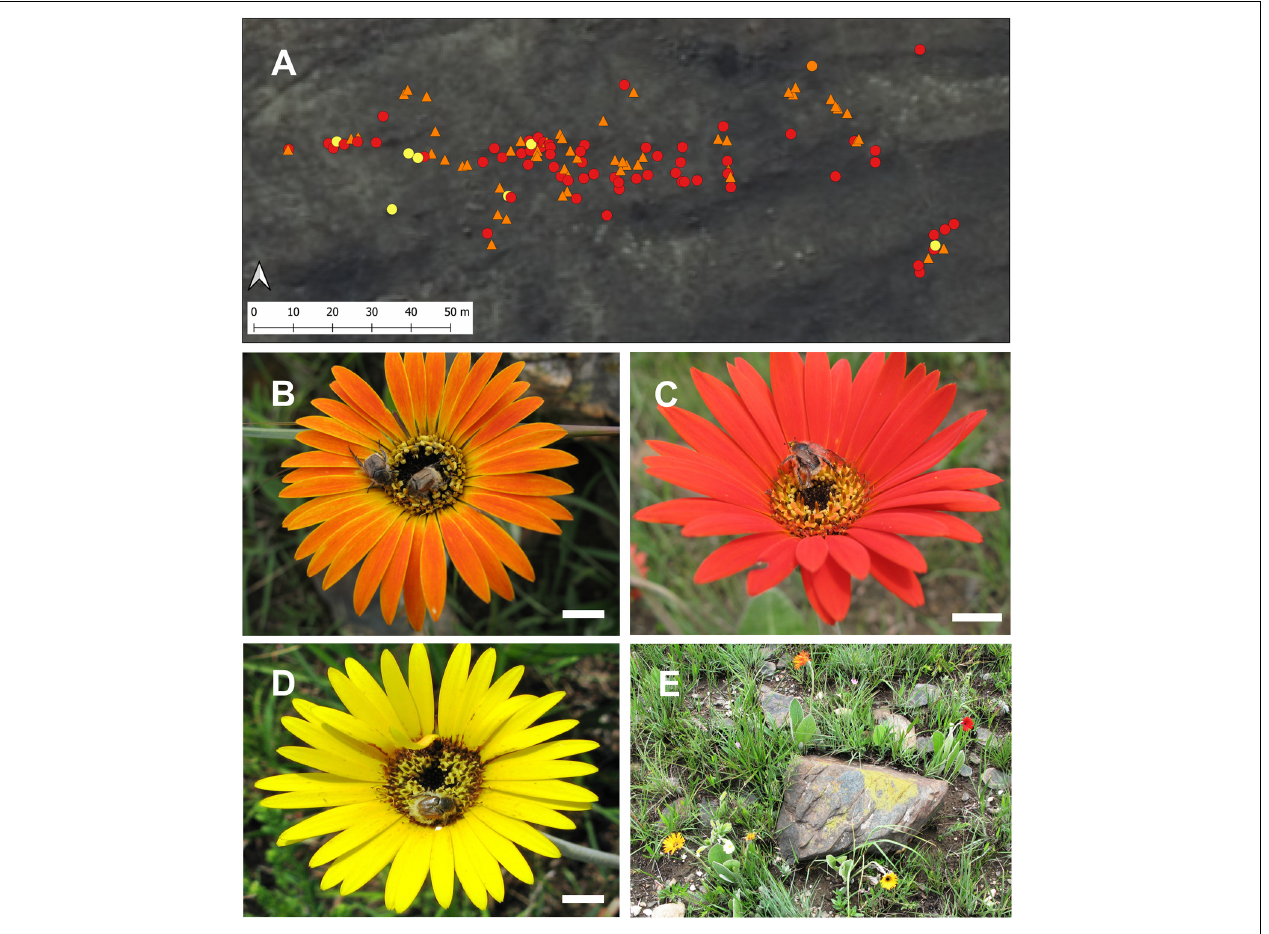
FIGURE 4 | (A) Map showing gps positions of Gerbera aurantiaca capitulum color forms in the polymorphic RH population, (B–D) Eriesthis vulpina beetles visiting orange, red and yellow capitula (Scale bars = 1 cm), and (E) different color forms growing in close proximity in the RH